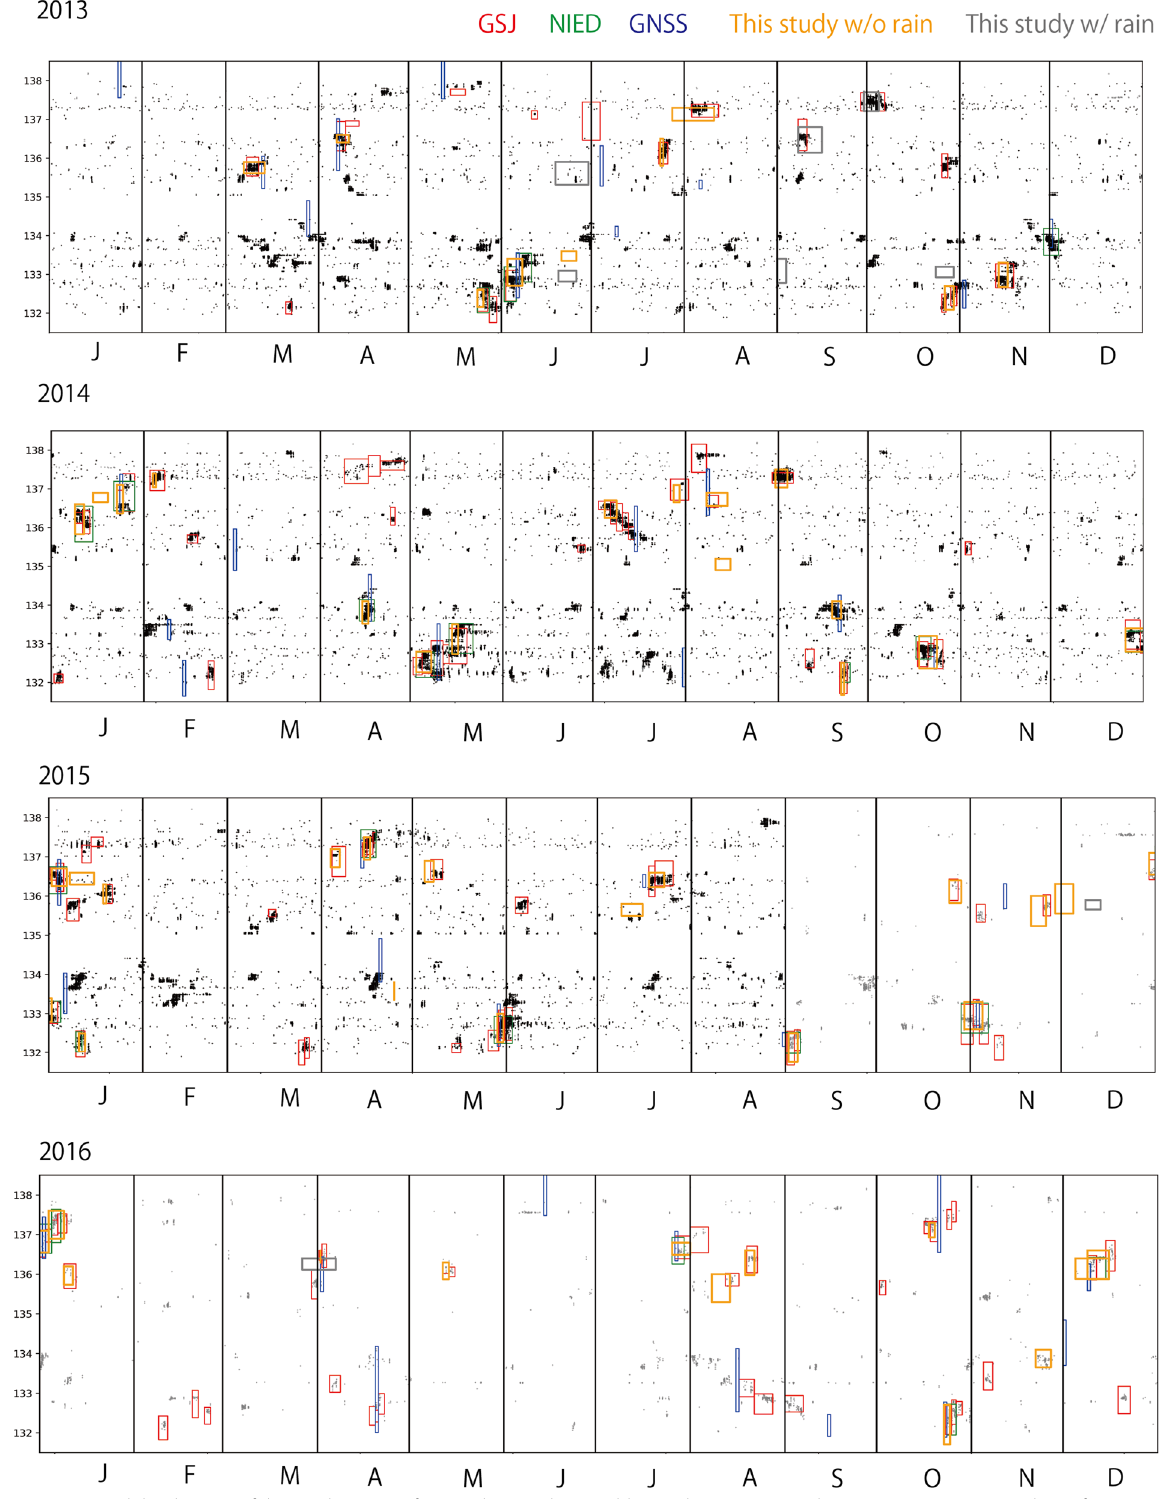
Fig. 7 Temporal distributions of detected events in four catalogs. Red, green, blue, and orange rectangles represent events in catalogs of GSJ, NIED, GNSS, and this study, respectively. Gray and black dots represent LFE catalogs of JMA and Kato and Nakagawa (2020),